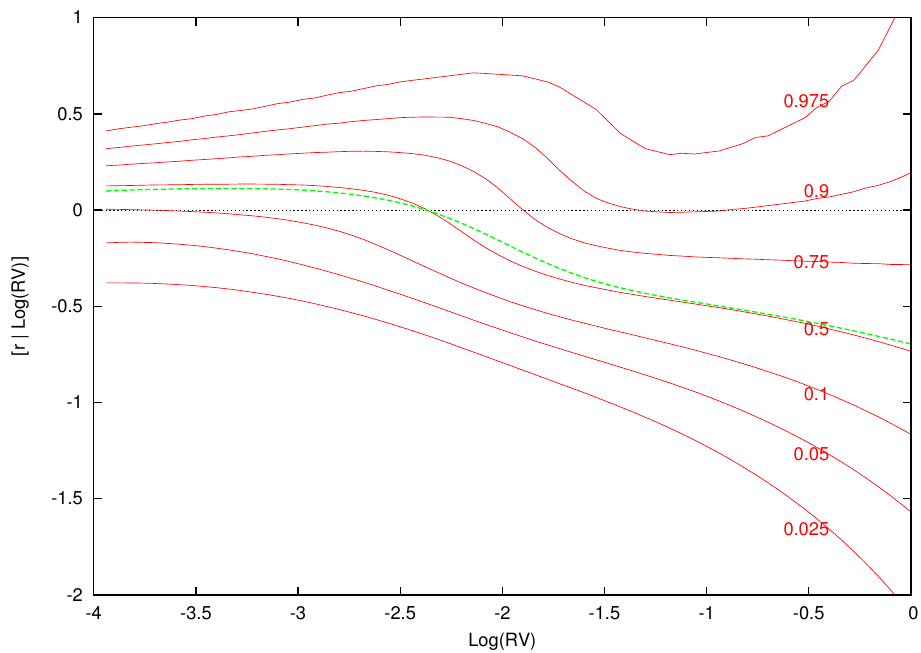
Figure 11. Quantiles of excess returns given log ( RV ) for low volatility. This figure displays the quantiles of the distribution of excess returns conditional on log ( RV ) for I t − 1 , t = 1964 : 10. The green dotted line is the expected excess return given log ( RV ) .